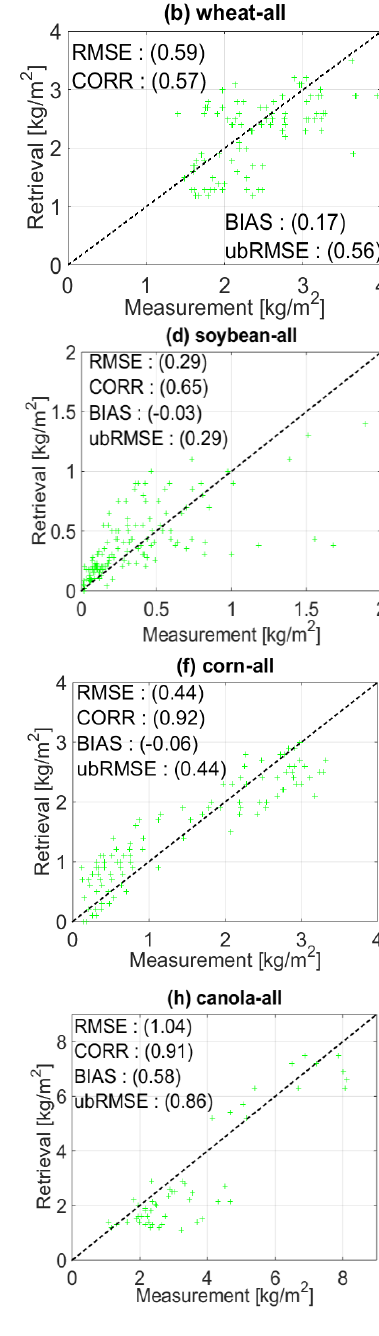
Figure 5. Retrievals of VWC using SMAPVEX12 data at one field (the field number is shown on the title) and over all the fields. The corn results are from [29].